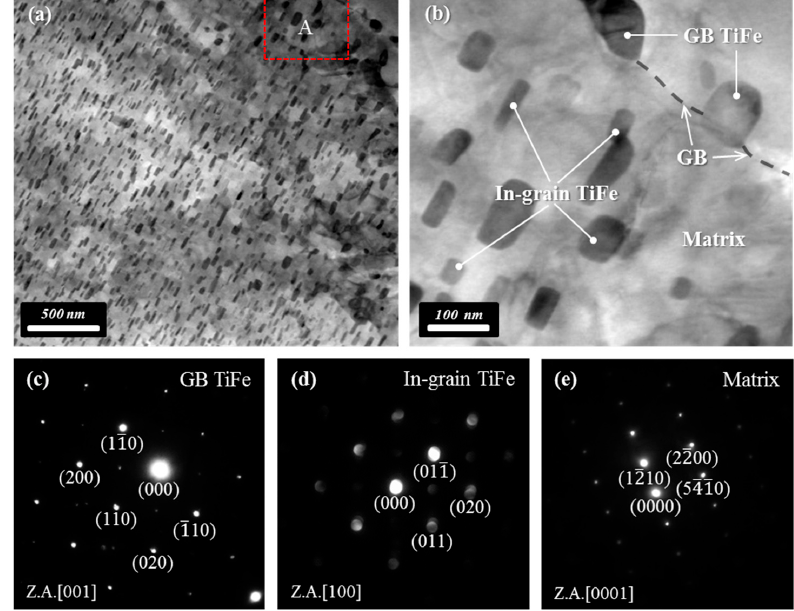
Figure 4. TEM analysis results of Ti-5Al-3.5Fe alloy after aging for 10 h. ( a ) Bright-field image, ( b ) magnification of the area A indicated in ( a ), and ( c – e ) diffraction patterns of three important phases observed in ( b ).